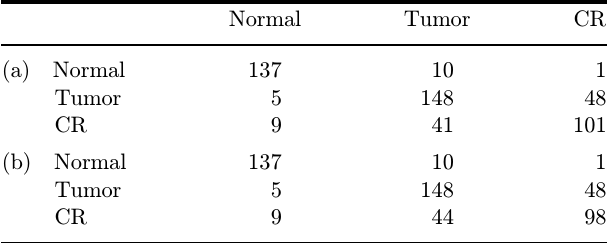
Table 1. PC-LDA for normal, tumor and complete responders: (a) standard model, (b) leave-one-out cross-validation (diag- onal elements are true positive predictions and ex-diagonal elements are false positive prediction).